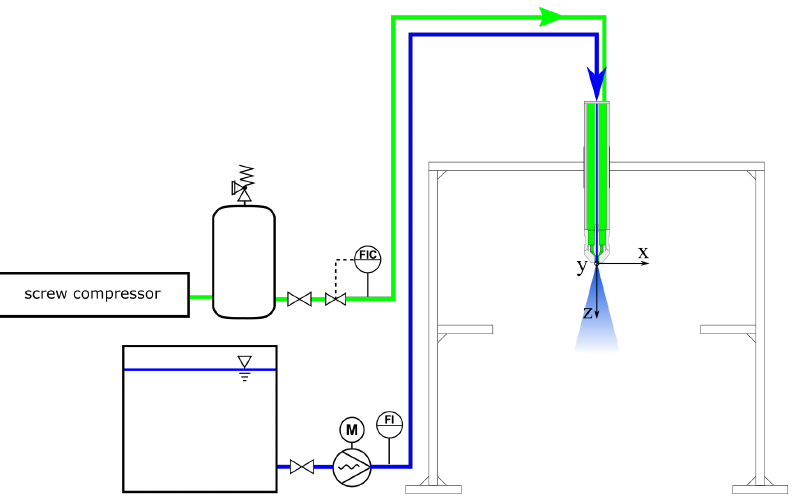
Figure 2. Schematic of experimental setup—Burner Test Rig (BTR). Table 1. Dimensions of applied atomizers at nozzle orifice for v liq = 1.7 m · s − 1